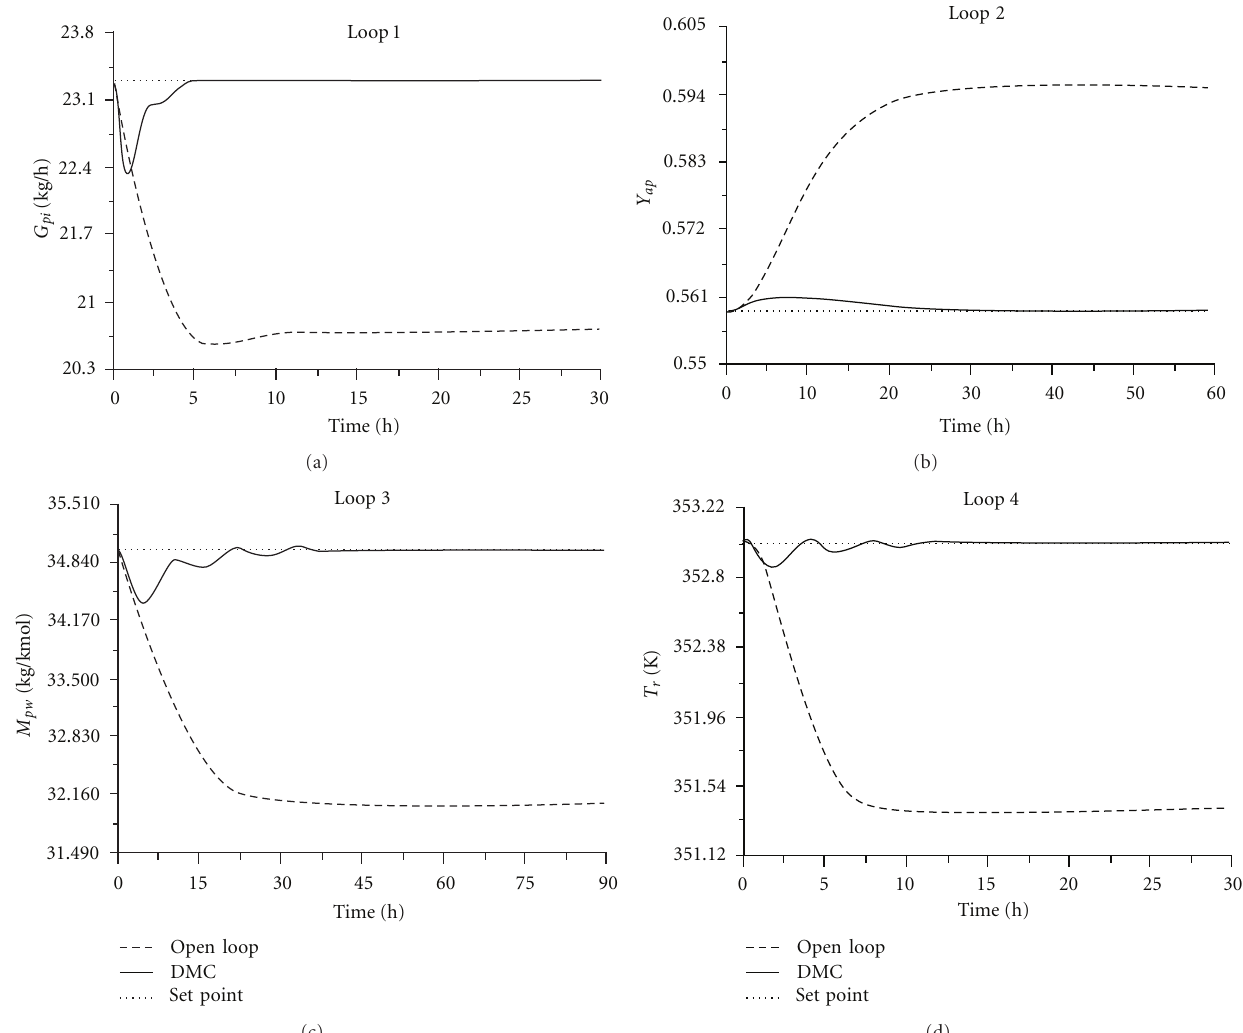
Figure 5: Closed-loop and open-loop simulations for an inhibitor disturbance of 4 parts per 1000 (mole basis).